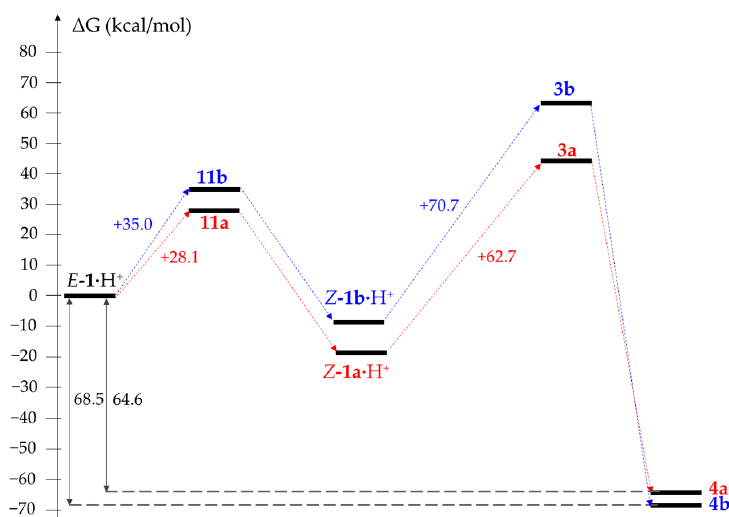
Figure 4. Comparison of reaction profiles for E - 1a → 4a (red) and E - 1b → 4b (blue) via “zwitterionic” path B.